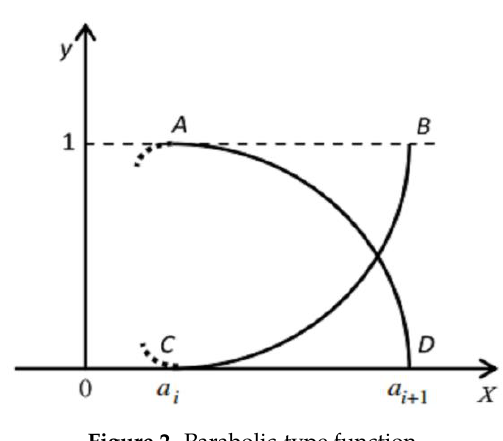
Figure 1. Linear-type function.